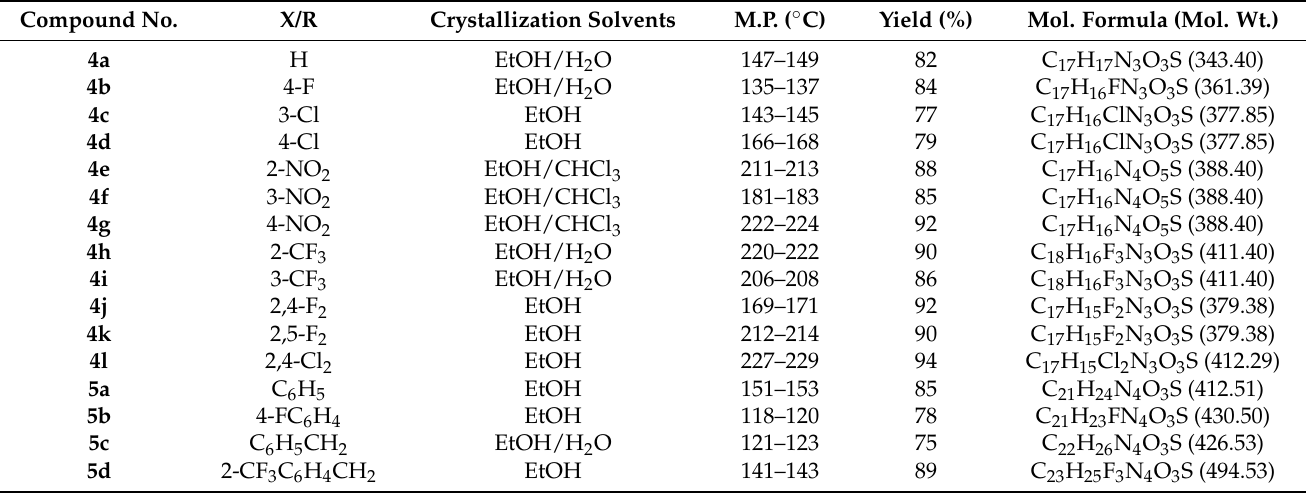
Table 1. Crystallization solvents, melting points (M.P.), yield percentages, molecular (Mol.) formulae, and molecular weights (Wt.) of compounds 4a – l and 5a – d . Compound